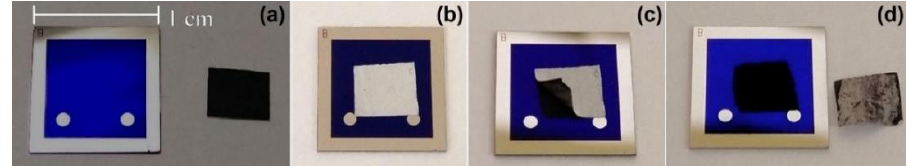
Figure 1. Schematic representation of the substrate cross-section.